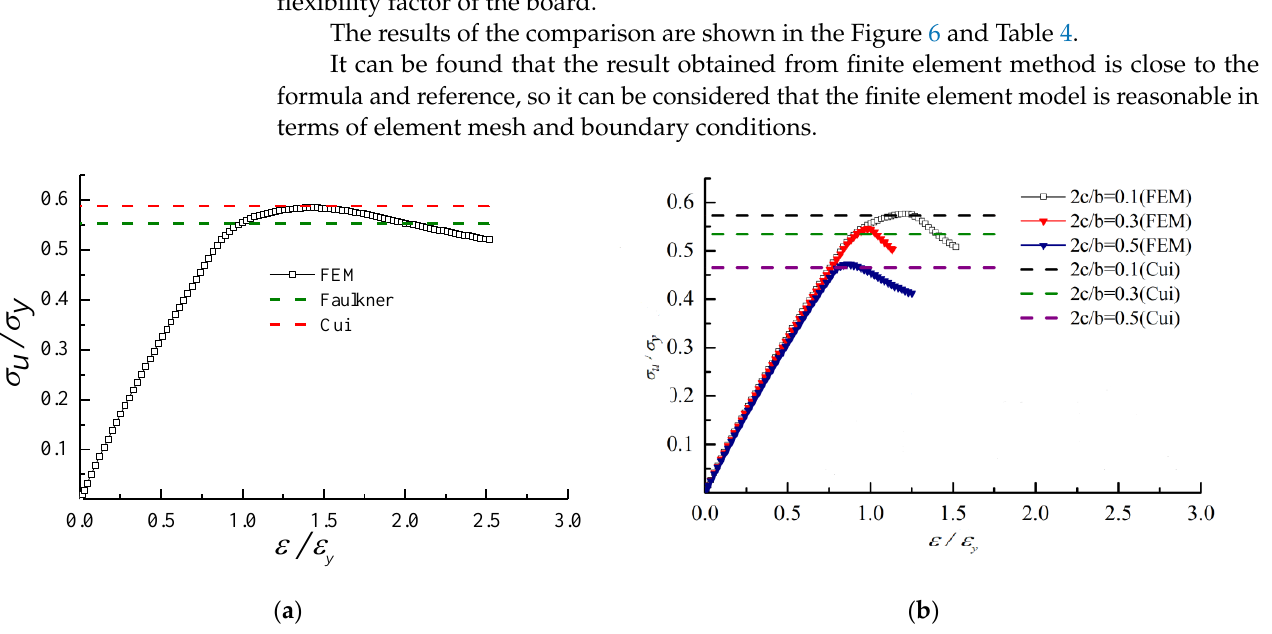
Figure 6. The stress-strain curve of ( a ) intact plate and ( b ) cracked plates.